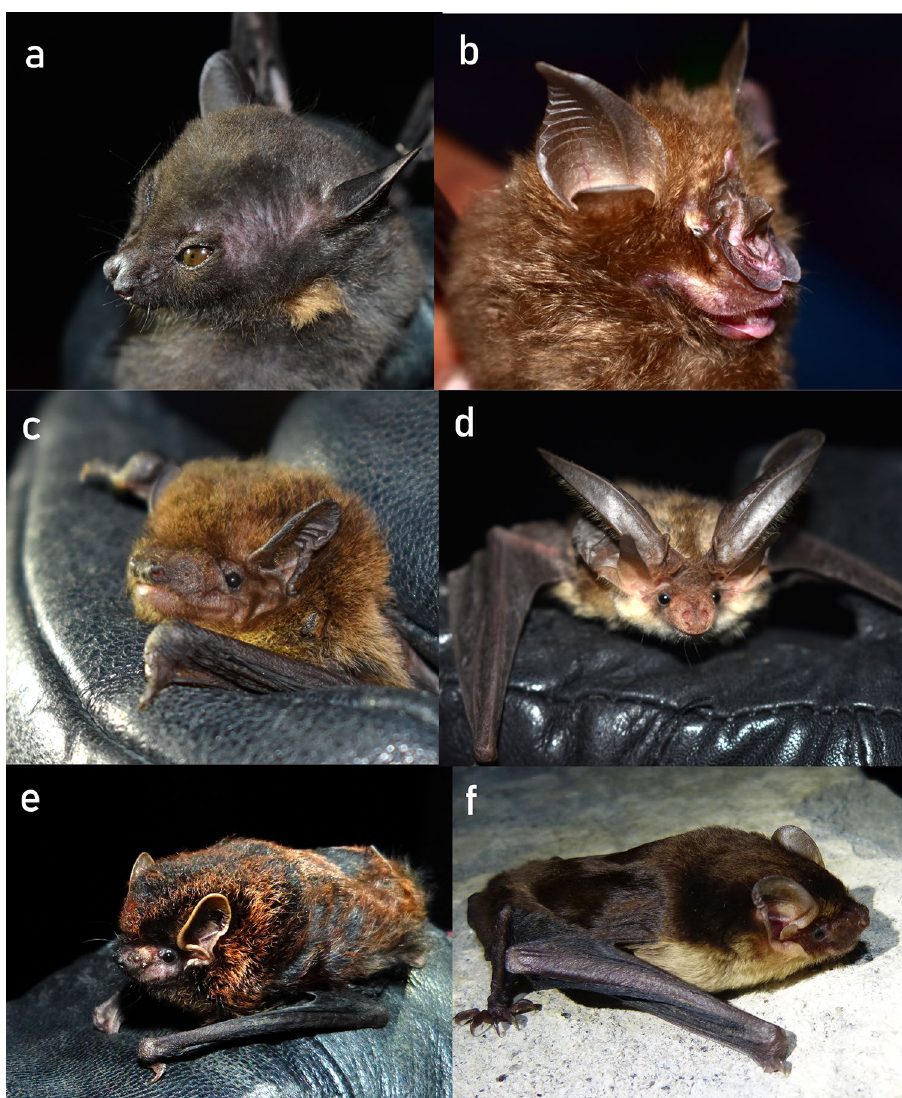
Figure 2. Portraits of some bat species found in Kedarnath Wildlife Sanctuary that represent different functional and phylogenetic groups. ( a ) Sphaerias blanfordi , ( b ) Rhinolophus pearsonii , ( c ) Pipistrellus cf. ceylonicus , ( d ) Plecotus wardi , ( e ) Arielulus circumdatus and ( f ) Mirostrellus joffrei . All photos by the first